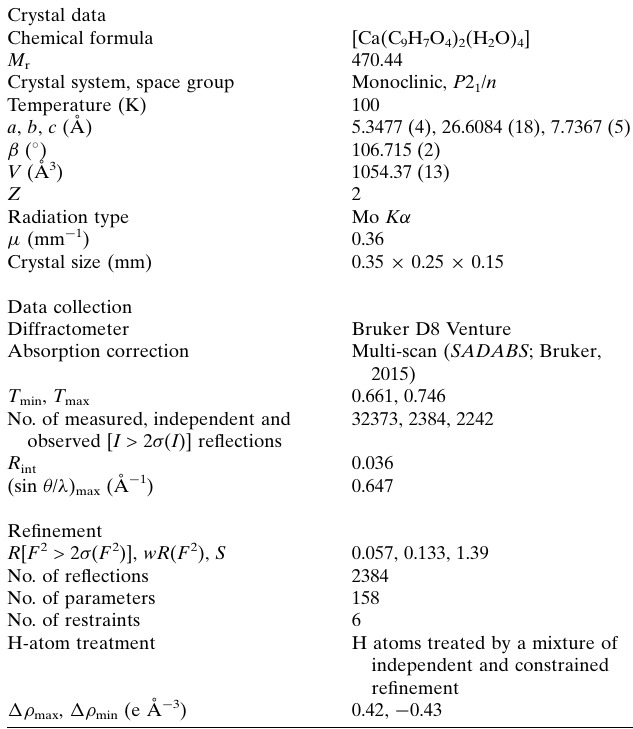
Table 2 Experimental details. Crystal data Chemical